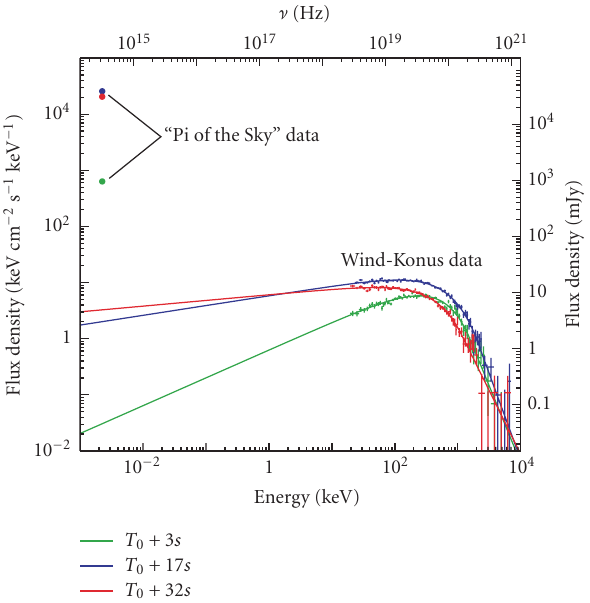
Figure 7: Spectral Energy Distribution of the prompt emission of GRB 080319B [18].